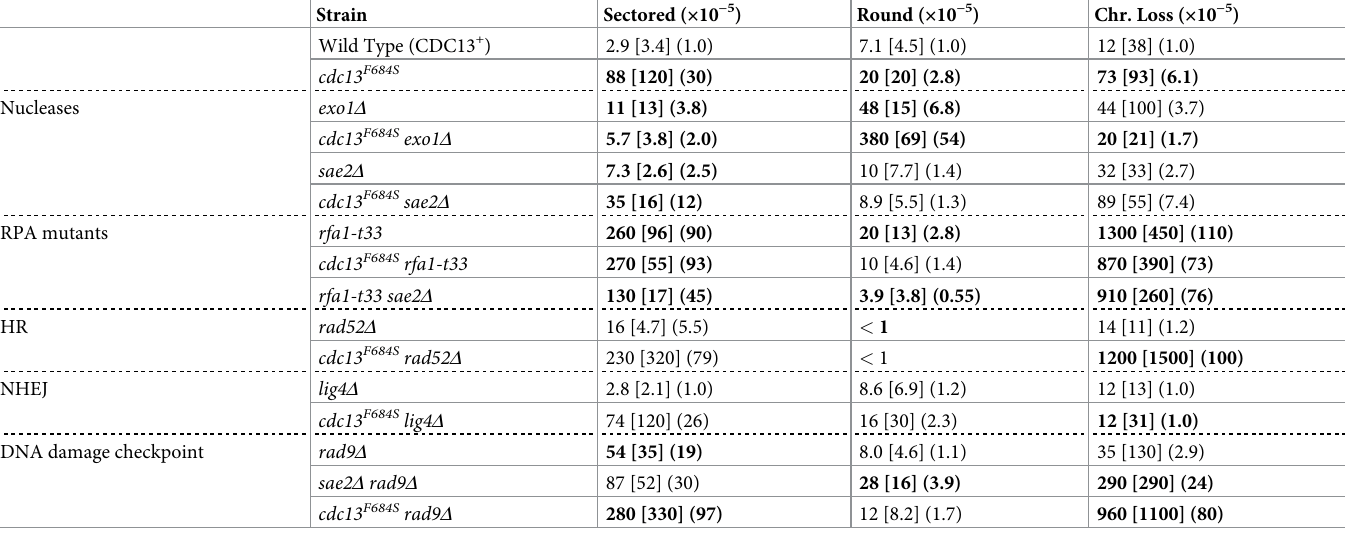
Table 2. Median frequencies of chromosome instability in cdc13 F684S mutants at